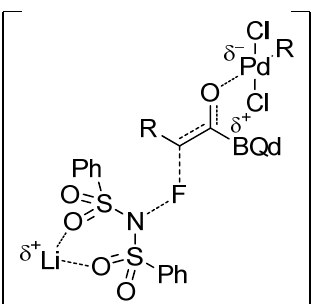
Figure 4. Proposed activation mode of the trifunctional catalytic